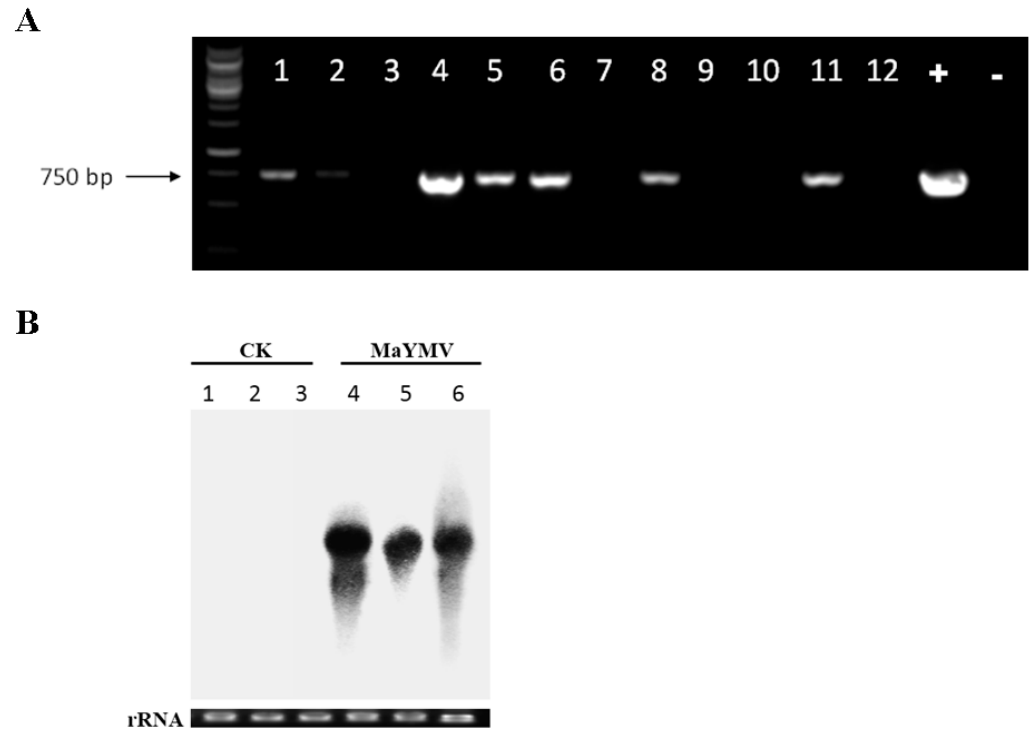
Figure 6. Agroinoculation infectivity assays using pCB301-MaYMV and N. benthamiana plants. ( A ) RT-PCR analysis of not inoculated (systemic) leaves infected by MaYMV. The numbers from 1 to 12 correspond to individual plants inoculated with pCB301-MaYMV infectious clone. “+” represents the positive control (using plasmid pCB301-MaYMV as a PCR template); “ − “ represents the negative control (using the cDNA from mock-inoculated N. benthamiana as a PCR template); and ( B ) Northern blot analysis of MaYMV RNA obtained from pCB301-MaYMV-agroinoculated upper leaves of plants and the MaYMV CP ORF-derived cDNA probes. Equal loading of total RNA (20 μ g) was validated by ethidium bromide-stained agarose gels as indicated at the bottom of the panel. Numbers 1–3 correspond to the replicates of the negative control; numbers 4–6 are the replicates of samples from plants agro-inoculated with pCB301-MaYMV.